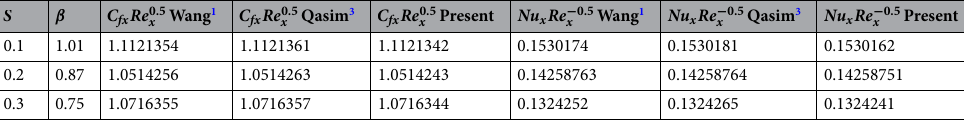
Table 4. Comparison of the current results and published work considering common